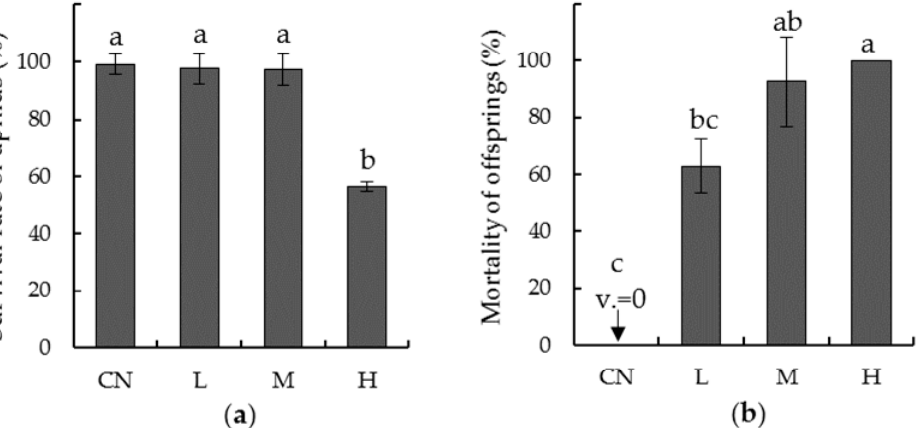
Figure 1. Effect of imidacloprid seed treatments on ( a ) aphids’ and ( b ) their offspring’s survival rate. CN: Control; L: Seed coated by low imidacloprid dose; M: Seed coated by medium imidacloprid; H: Seed coated by high imidacloprid dose. Bars indicate standard errors. Bars with the same letters are homogeneous groups or are not statistically different. v. = value.